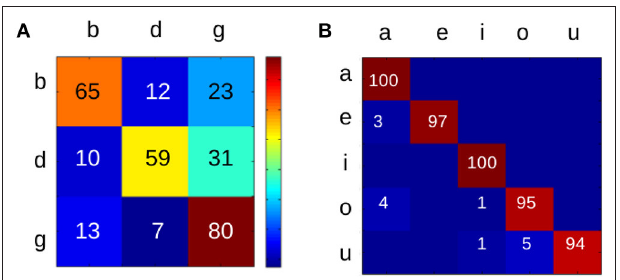
FIGURE 6 | Confusion matrices for the intelligibility of the synthetic speech. Rows represent the produced phoneme and columns the transcribed one. (A) Consonants. (B) Vowels. The color code represents the percentage of responses for each